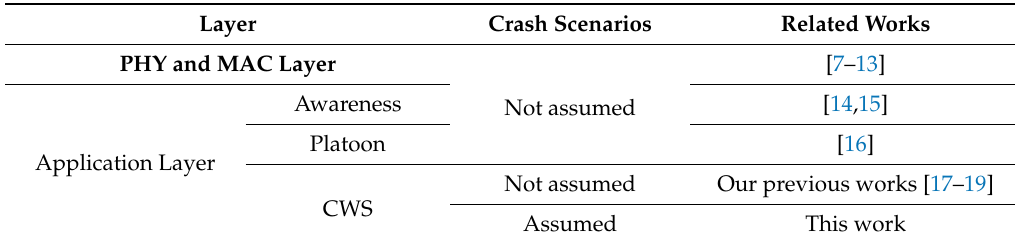
Table 1. Summary of related works in terms of evaluated